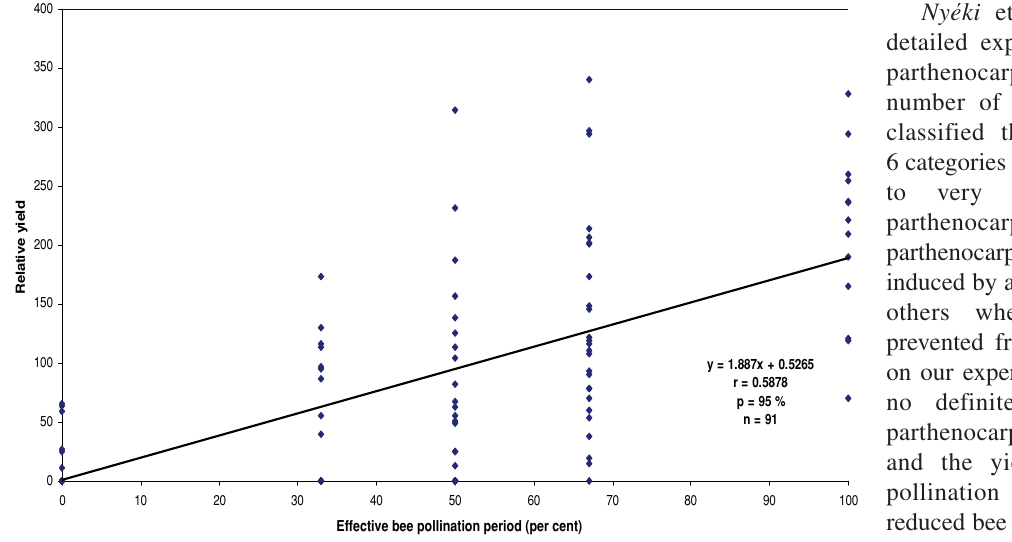
Figure1. Yield of pear as a function of the effective bee pollination period: Gyôr 2007 + Mosonmagyaróvár 2008 (13 cultivars)